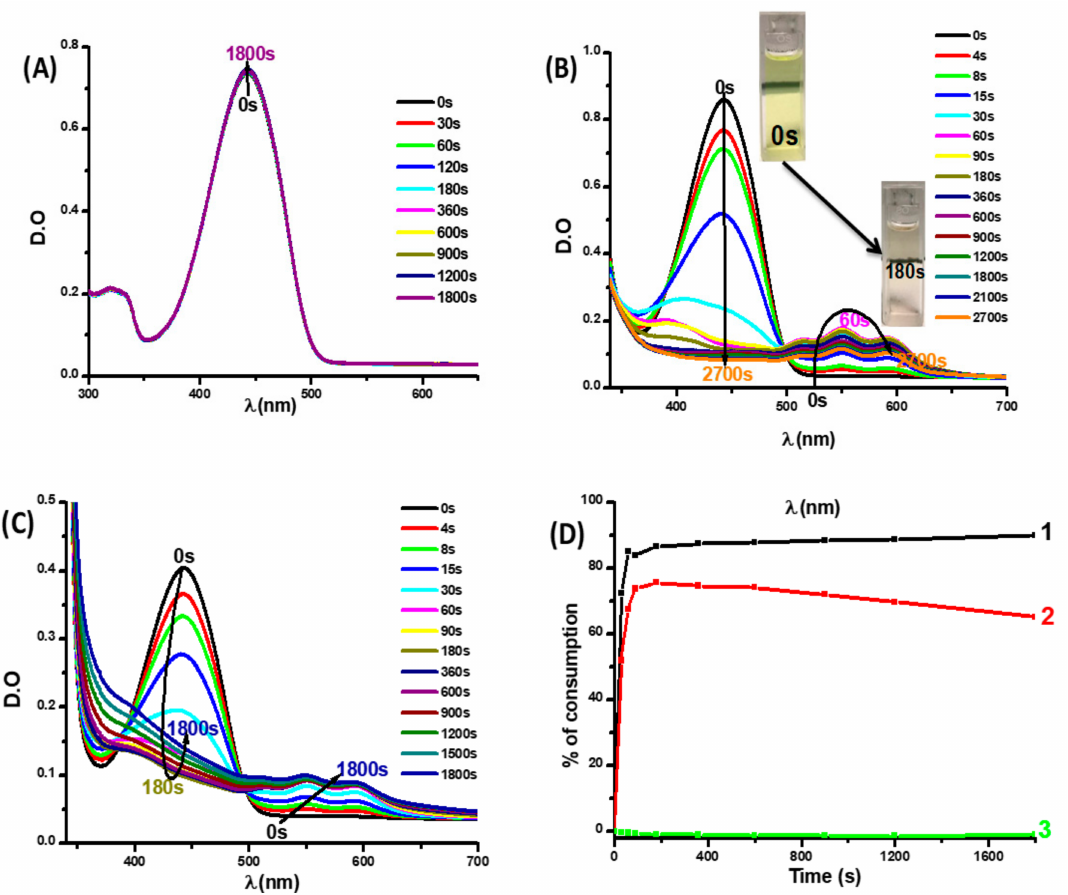
Figure 7. Photolysis of Coum2 in acetonitrile upon exposure to the LED @ 405 nm: ( A ) Coum2 alone ( B ): With Iod (10 − 2 M); and ( C ) With Iod / EDB (10 − 2 M). ( D ) Consumption of Coum2: (1) With Iod, (2) With Iod / EDB, and (3) Without Iod vs. irradiation time upon exposure to the LED @ 375 nm in